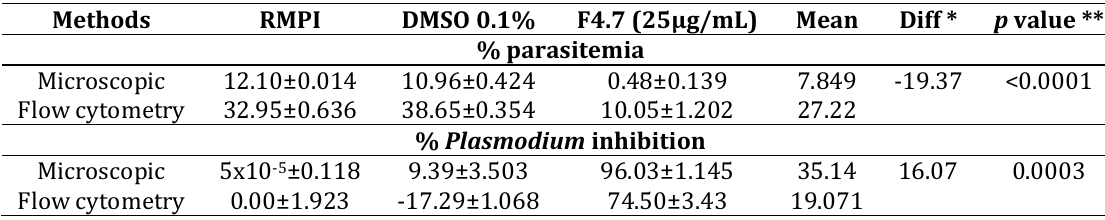
Figure 2. Fluorescens intensity of SYBR Green I on flow cytometry assay (A), parasitemia of Plasmodium falciparum 3D7 on microscopic assay (B). 1: Infected red blood cells (RBC) on RPMI medium (control), 2: Infected RBC on RPMI medium+ 0.1% DMSO, 3: Infected RBC on 25 µg/mL of F4.7 GMY01. Percentage of parasitemia (C) and percentage of Plasmodium inhibition (D) on antiplasmodial activities of F4.7 using microscopic and flow cytometry method. Value are expressed as mean ± SD (* p <0.05, ** p <0.01, *** p <0.001, **** p <0.0001). Table II. Statistical analysis of interaction between two methods on antiplasmodial assay